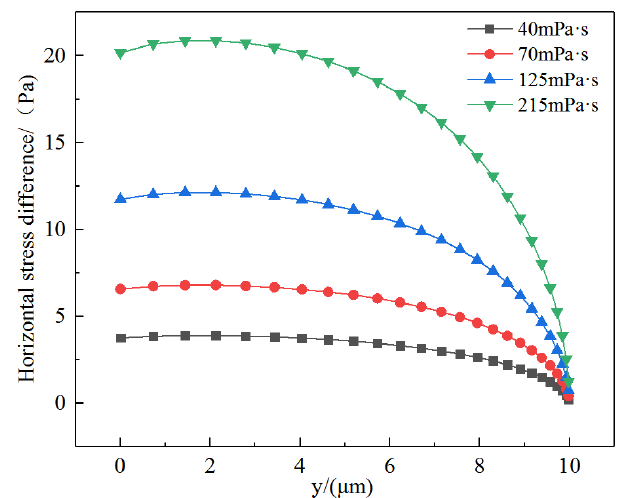
Figure 9. Variation of horizontal stress differences.